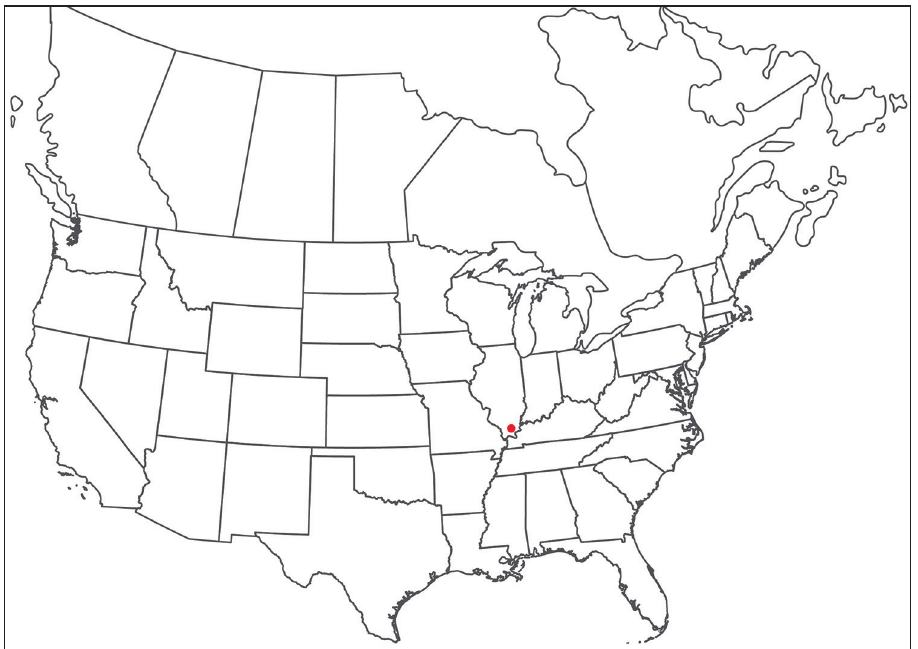
Figure 202. Torrenticola pulchra sp. n.